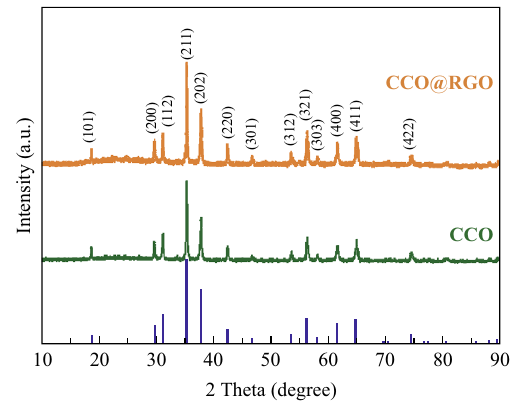
Fig. 1 XRD patterns of CCO and